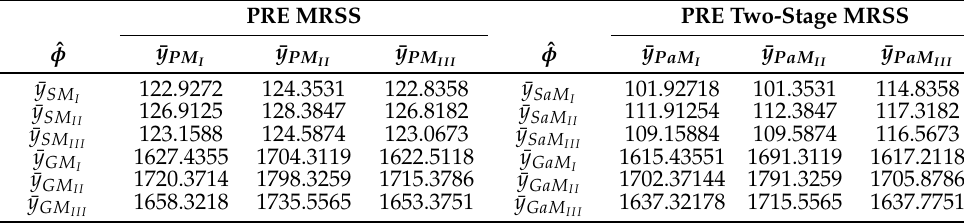
Table 7. PRE values for ( A 3 , B 3 ) .